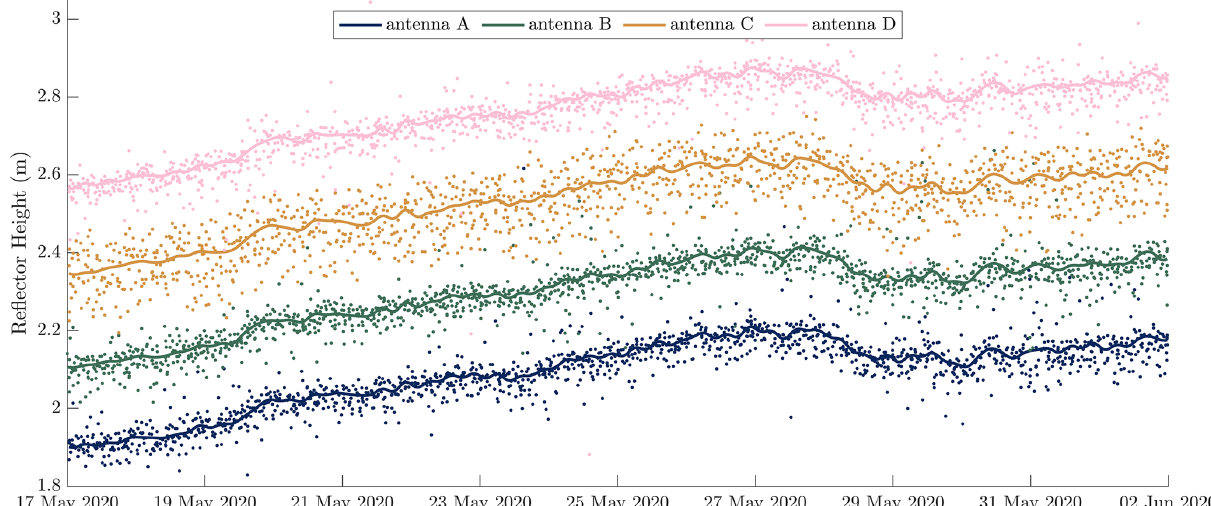
Figure 5. Reflector height measurements from four antennas at Sainte-Anne-de-Bellevue. The solid lines represent the b-spline solutions from inverse modelling and the dots are estimates from spectral analysis. The b-spline parameters that are used to plot the solid lines in this figure are averaged to form the single solution in Fig. 4b. The curves are inverted because reflector height increases as water level decreases.